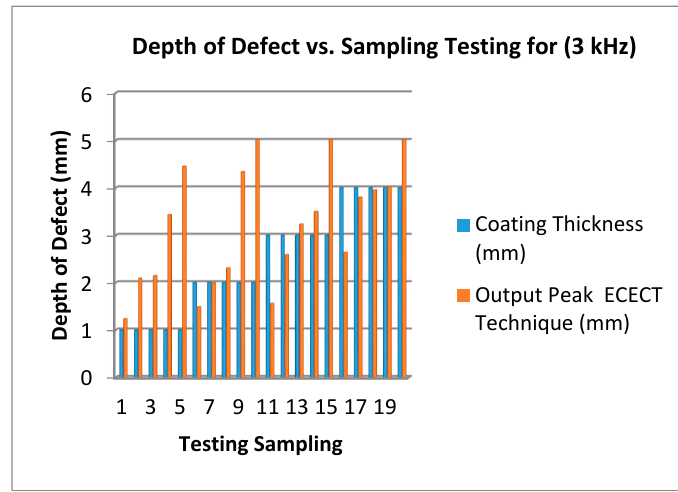
Figure 14. Depth of Defect (mm) vs. Testing Sampling (3 kHz Frequency).